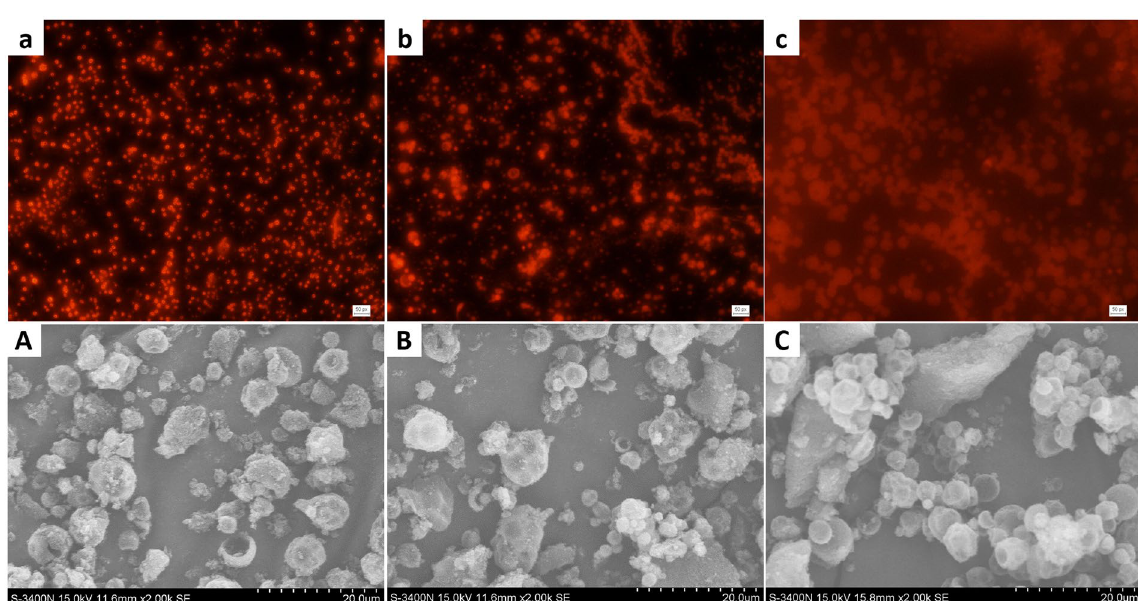
Figure 5. Fluorescence microscopies of the w/o/w multiple emulsions with different oil volume fractions of ( a ) 80%, ( b ) 50% and ( c ) 30% and the oils are styrene. All of the scale bars are 50 μ m. A, B and C are the SEM photos of the polystyrene particles prepared from the corresponding multiple